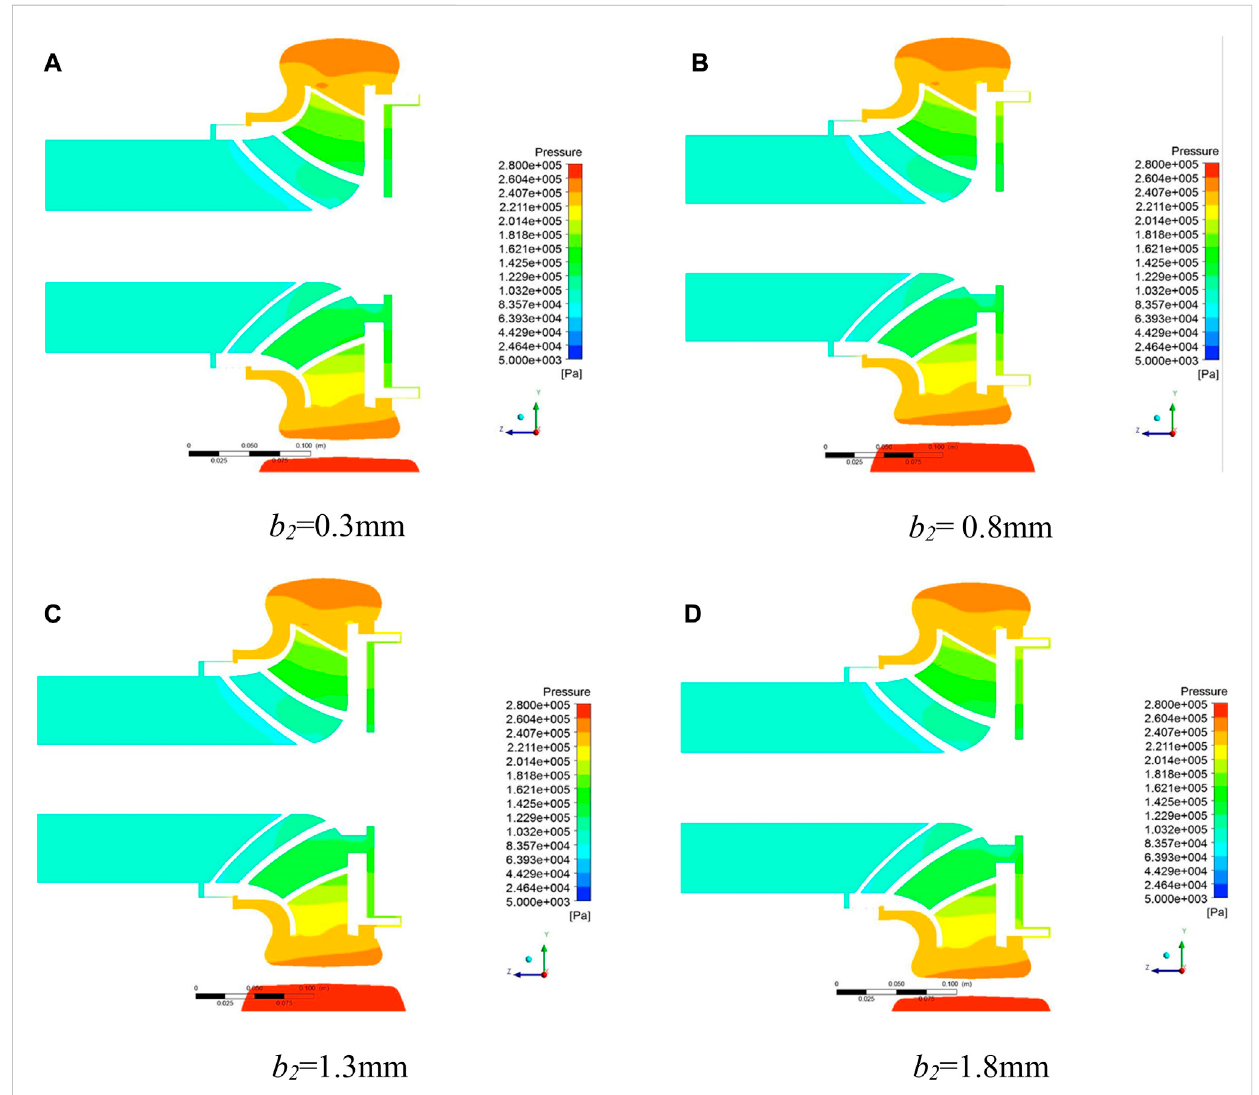
FIGURE 7 The static pressure distribution of X = 0 section under different clearance of back wear-ring. (A) b 2 = 0.3 mm; (B) b 2 = 0.8 mm; (C) b 2 = 1.3 mm; (D) b 2 = 1.8